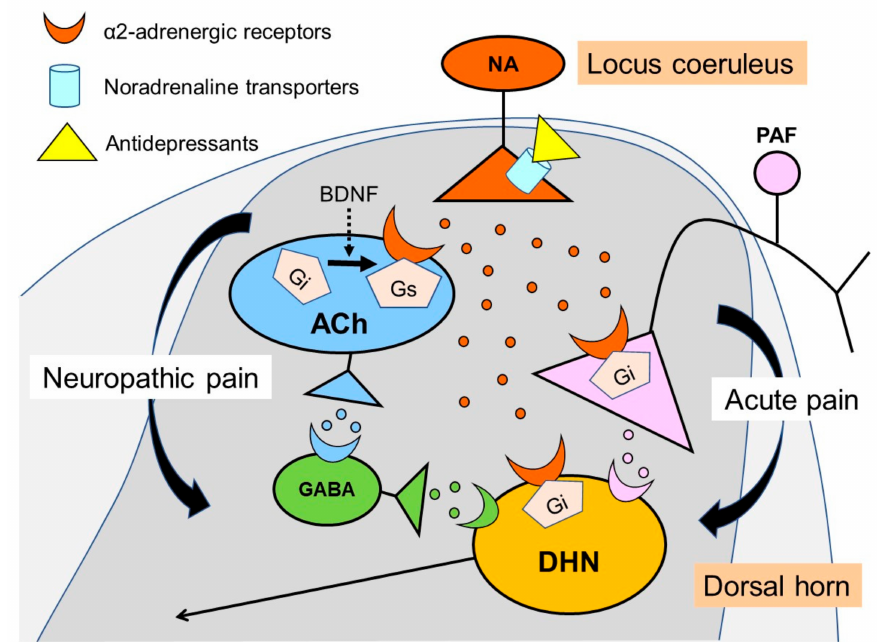
Figure 1. Schematic illustration of analgesic effects of antidepressants and noradrenaline in the dorsal horn of the spinal cord. Antidepressants increase noradrenaline via blocking of noradrenaline transporters at the terminal of the descending noradrenergic fiber from the locus coeruleus. Noradrenaline inhibits acute pain through α 2 -adrenergic receptors by pre-synaptic (inhibit neurotransmitters release) and post-synaptic (hyperpolarize cell membranes) mechanisms. In neuropathic pain states, however, α 2 -adrenergic receptors in the cholinergic interneurons change from inhibitory to excitatory through G-protein switch (from Gi to Gs) by the effect of brain-derived neurotrophic factor (BDNF) increasing after nerve injury. Released acetylcholine bind to muscarinic receptors, by which produce analgesia thorough GABA release. PAF; primary afferent fibers, NA; noradrenaline, DHN; dorsal horn neurons, ACh; acetylcholine, Red circle; noradrenaline, Blue circle; acetylcholine, Green circle; GABA, Pink circle; excitatory